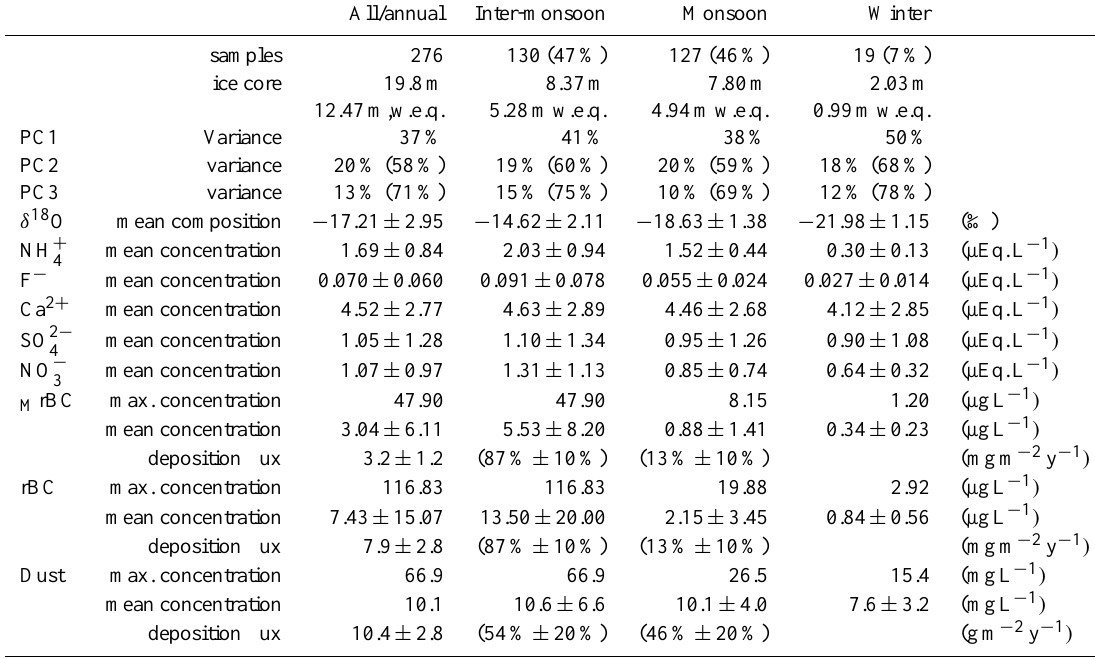
Table 1. Summary data: EOF analysis parameters and aerosol concentrations and fluxes obtained from the Mera Glacier ice